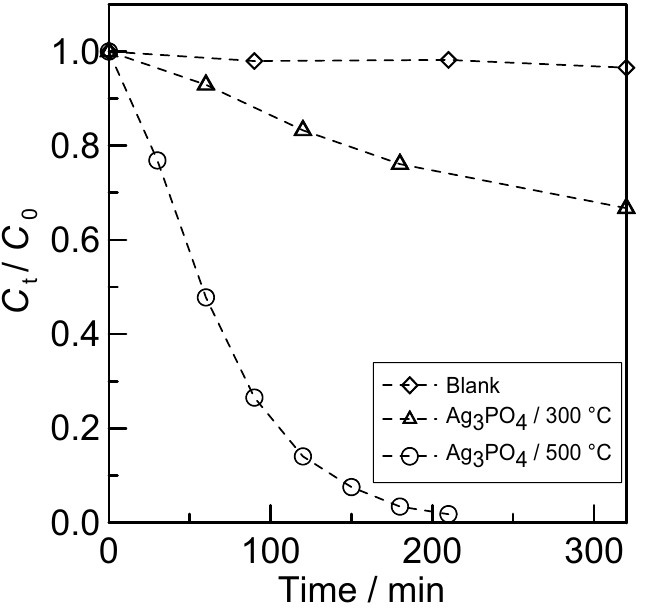
Figure 10. Time course of specific concentration C t / C 0 of methylene blue under blue LED illumination for (1) substrate only, (2) silver phosphate coated substrate (calcined at 300 °C), and (3) silver phosphate coated substrate (calcined at 500 °C). Here, C 0 is the initial concentration of methylene blue and C t is the concentration at time t